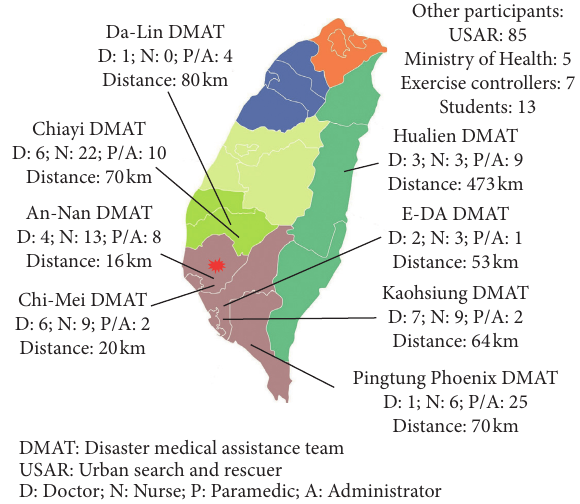
Figure 2: The basic characteristics of DMATs in this exercise. Table 1: The basic characteristics of the participants in this exercise.